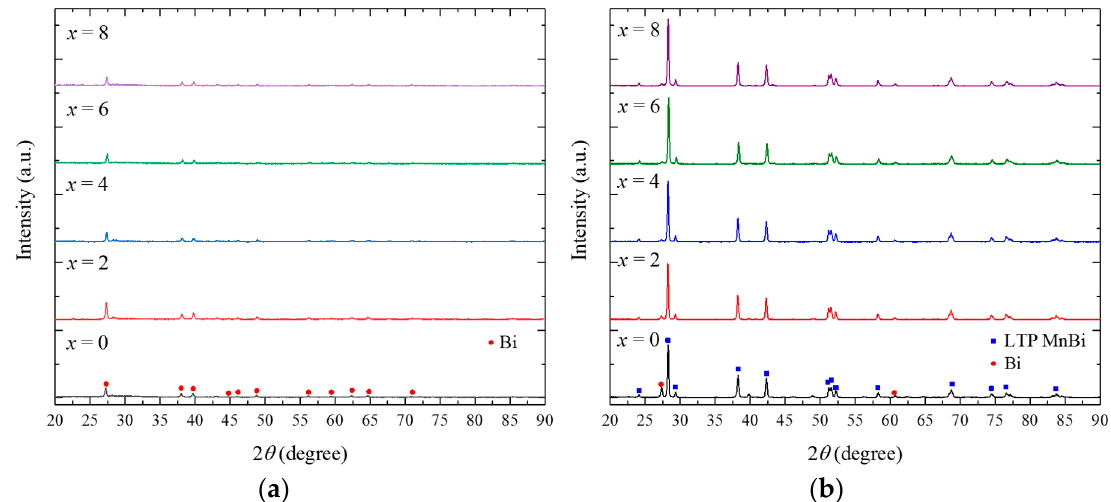
Figure 2. XRD patterns of the ( a ) ground Mn 52 + x Bi 48 − x melt-spun ribbons and ( b ) annealed bulk samples (300 °C for 24 h).